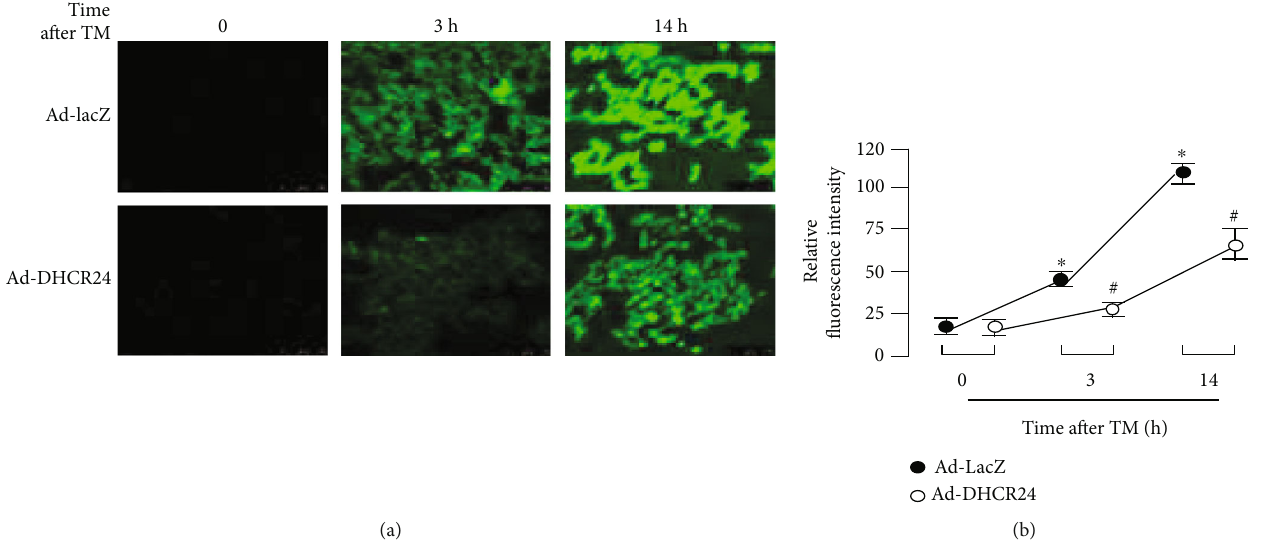
Figure 4: Excessive intracellular ROS is scavenged by overexpression of DHCR24. (a) Intracellular ROS were detected by application of the fl uorescent dye DCFHDA. Bar, 50 μ m. (b) The levels of intracellular ROS are represented by the relative fl uorescence of DCF (2 ′ ,7 ′ -dichloro fl uorescein). Mean ± S : D : ( n = 3 ). ∗ p < 0 : 05 vs. the levels at 0h after TM treatment. # p < 0 : 05 vs.